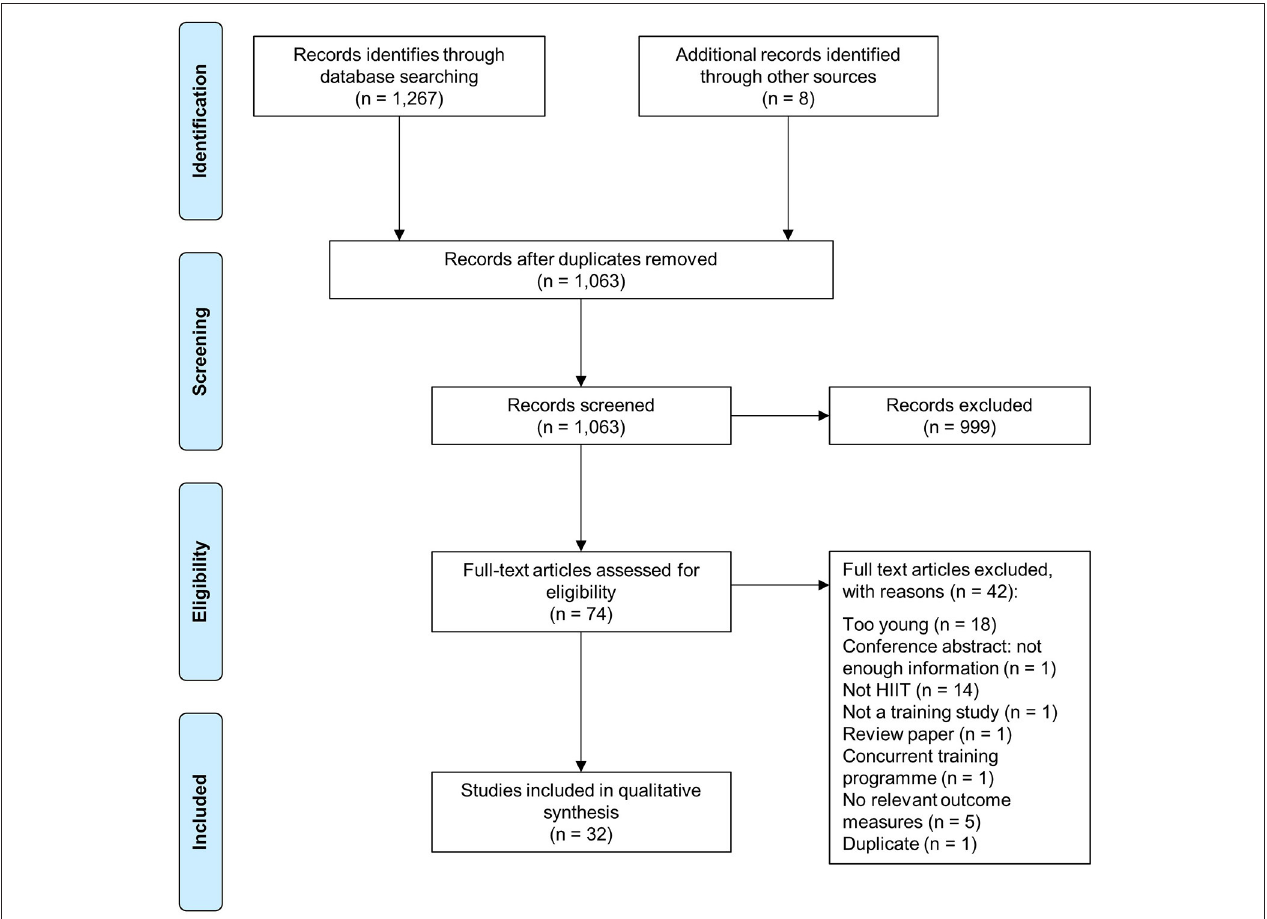
FIGURE 1 | Schematic flow diagram describing exclusions of potential studies and final number of